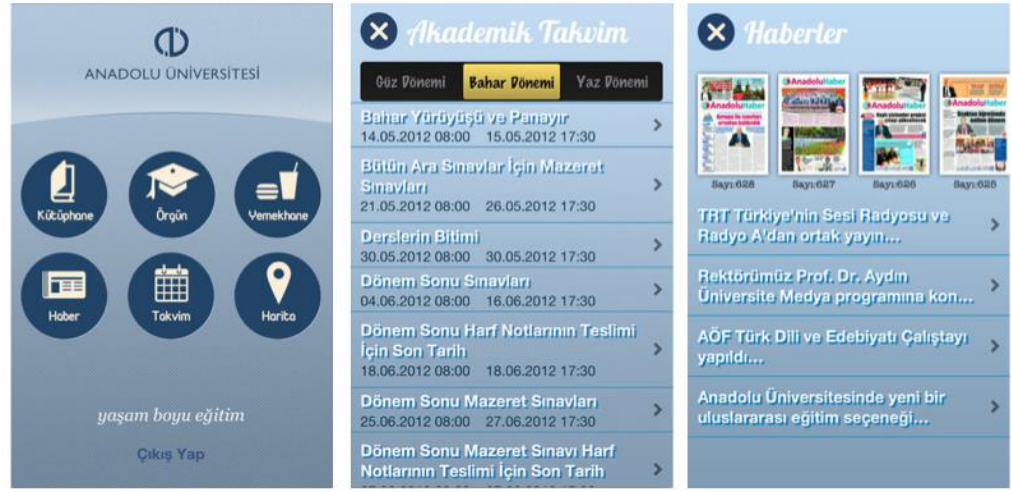
Figure 2 Version 1.2 screenshots from the iOS